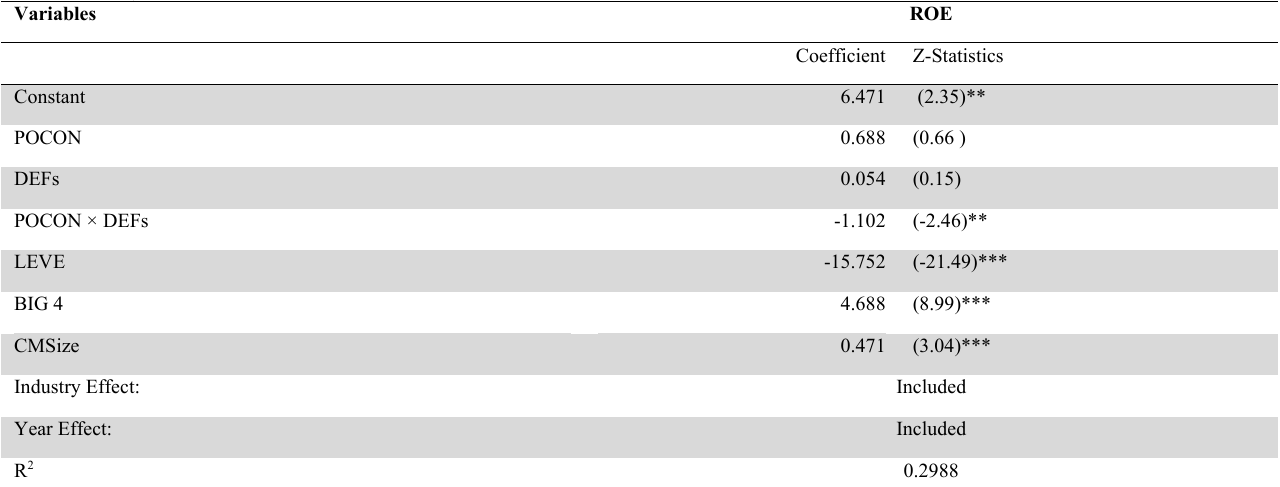
Main regression results (PCSE) of Moderating Effect of Director Financial Expertise (Dependent Variable= ROE and 2200